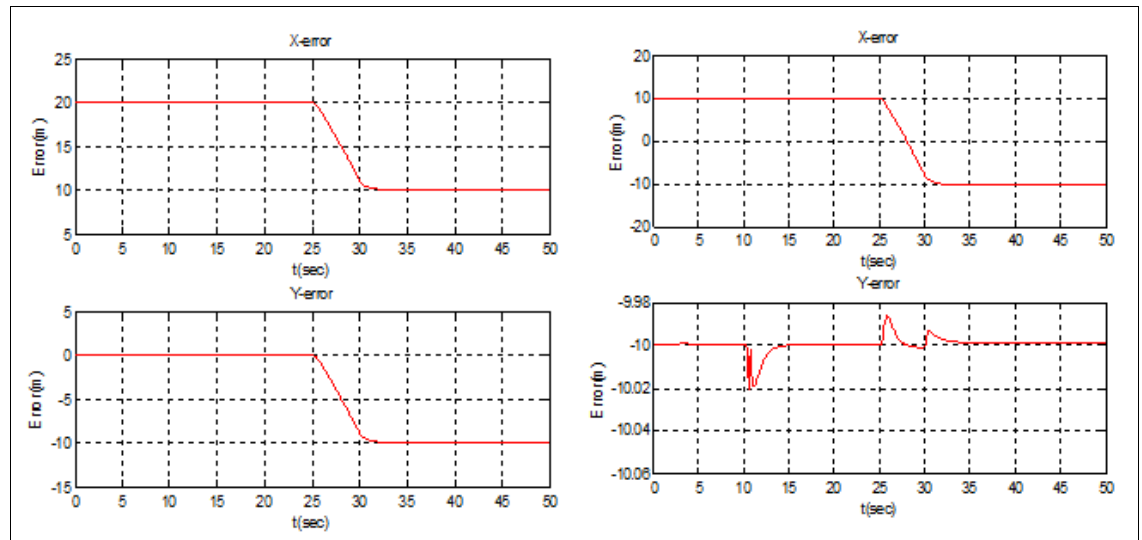
Figure 8. Leader election Case 1—tracking